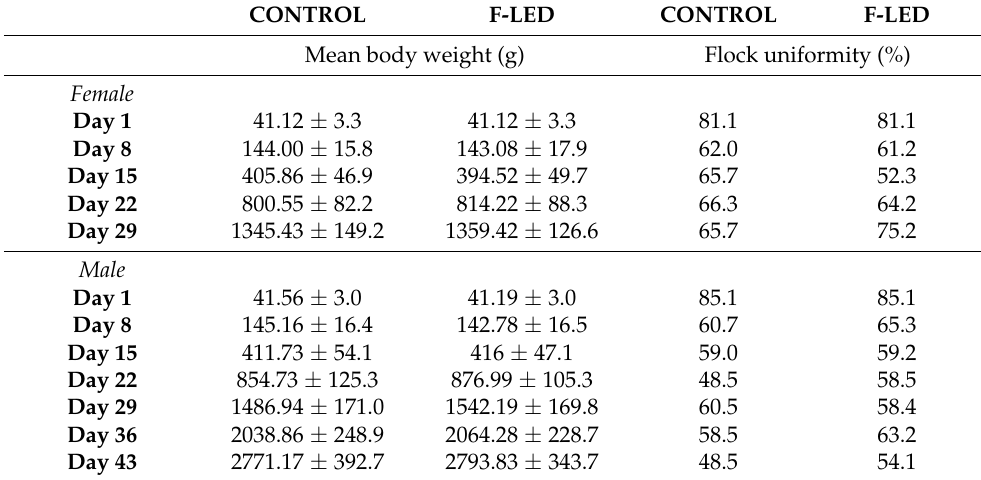
equipped with light-emitting diodes (F-LED): final body weight (mean ± standard deviation) and flock uniformity.